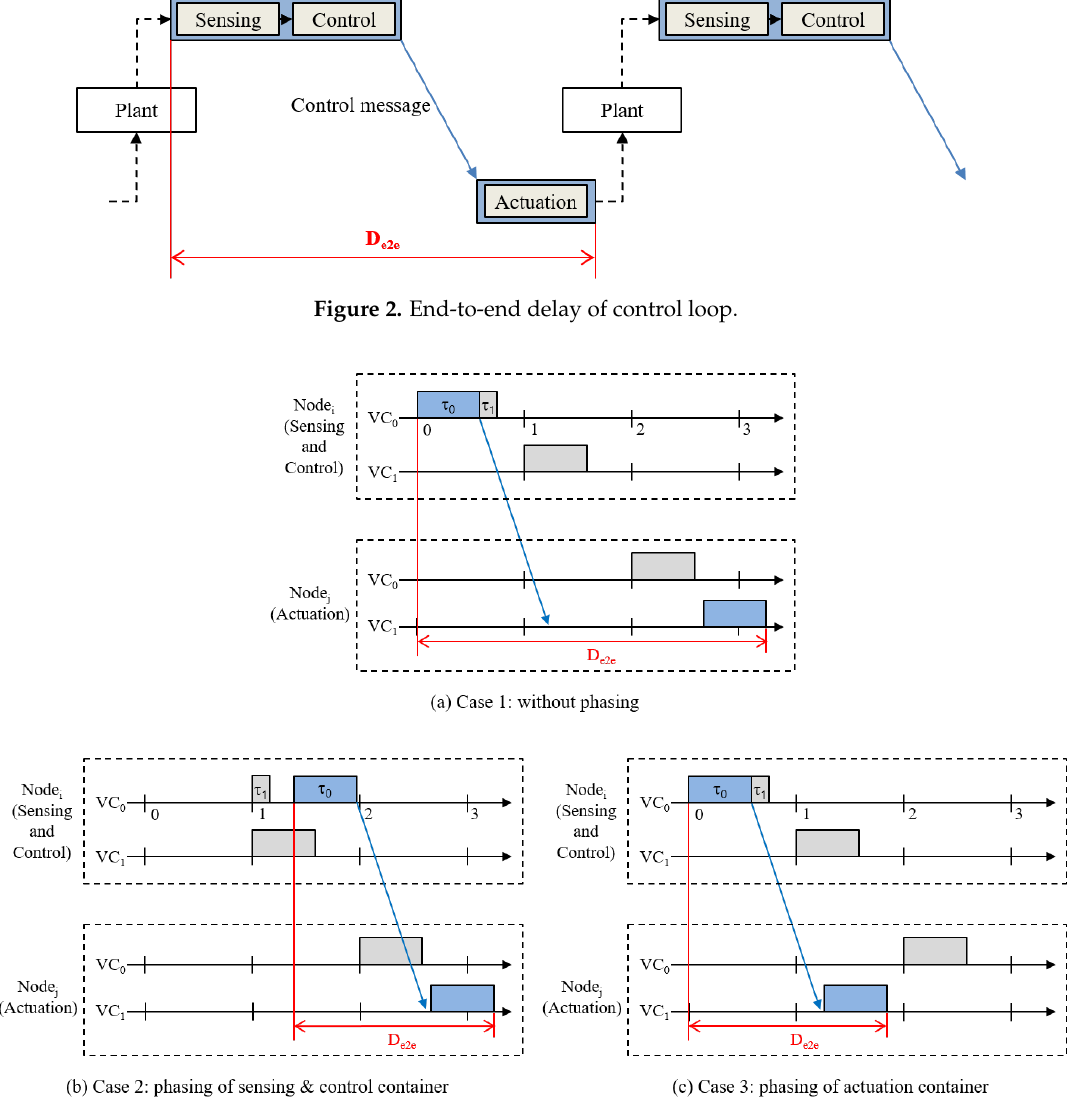
Figure 3. End-to-end delay and phase